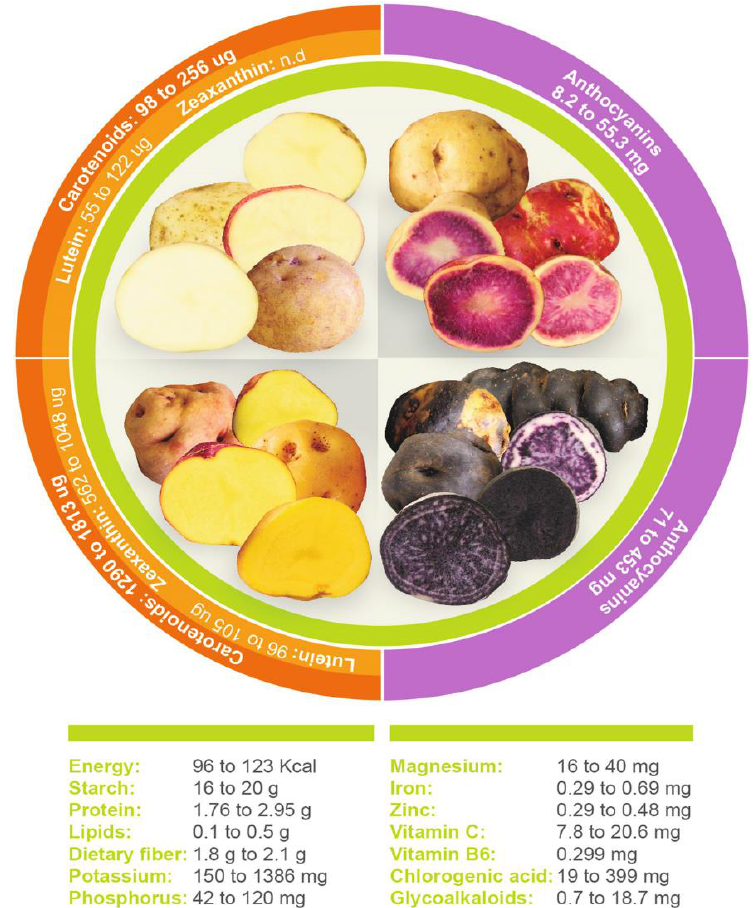
Figure 3. The nutritional composition of potato [17].